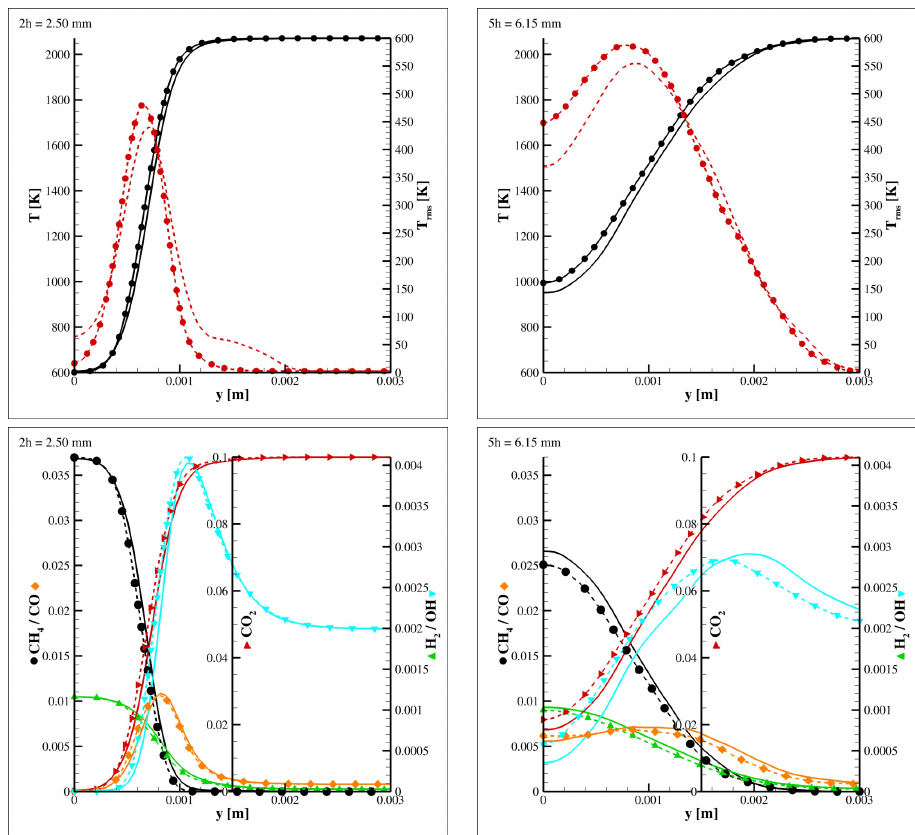
Figure 9. ( Top ) Transversal average (solid lines) and rms (dashed lines) temperature profiles at several heights above injection: comparison between LES (lines without symbols) and DNS data (lines with symbols). ( Bottom ) Transversal average mass fraction profiles: comparison between LES (solid lines) and DNS data (dashed lines), ◦ , CH 4 ; (cid:77) , H 2